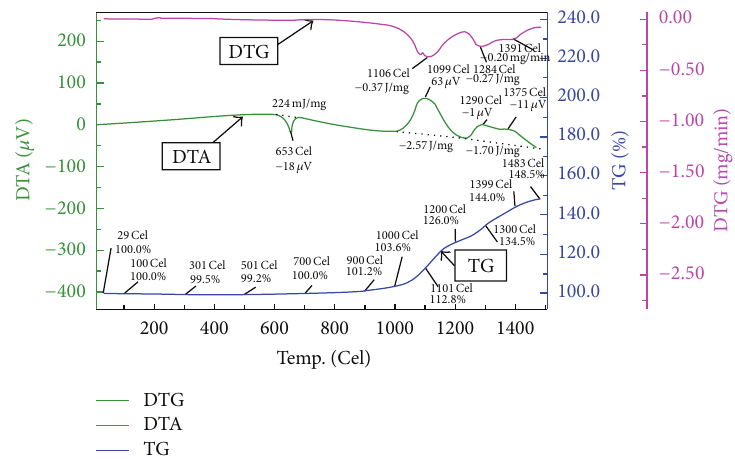
Figure 6: TG, DTG, and DTA graph of A6061/10% SiC composite.